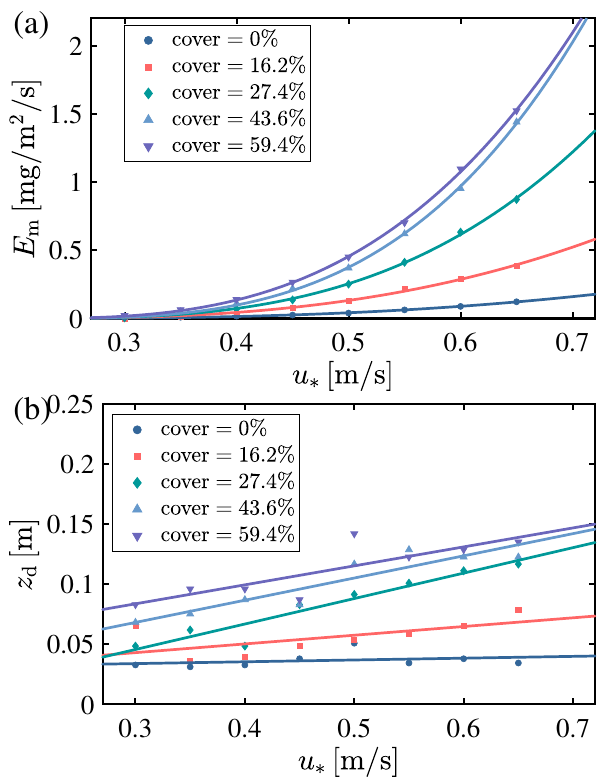
Figure 9. ( a ) The relationship between parameter E m and friction velocity u ∗ on Gobi with different gravel coverage. ( b ) The relationship between parameter z d and friction velocity u ∗ on Gobi with different gravel coverage. The solid line represents the fitting